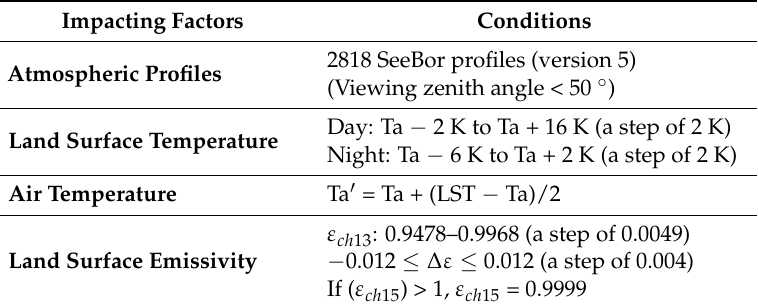
Table 1. Input conditions of RTM simulation according to impacting